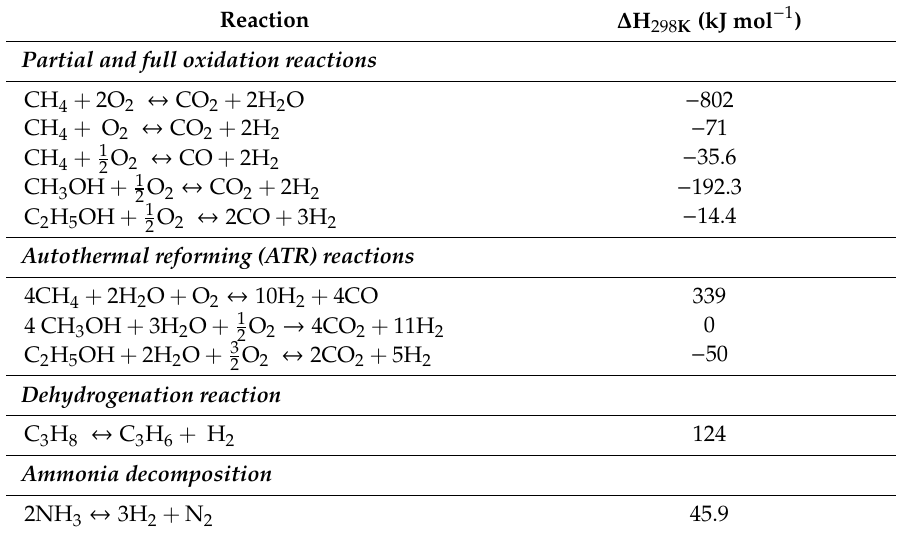
Figure 6. Methane equilibrium conversion in conventional system and comparison with membrane reactors at different pressures. In this case, the membrane reactor technology allows us to achieve the same conversions of a conventional system while working at much lower operating temperatures (550 °C for an MR compared to 850–900 °C for a conventional system). On top of it, as hydrogen is permeating through the membranes, the WGS reaction is shifted towards the products and a downstream separation is not required [20]. In another study, Matsuka et al. [21] performed membrane reactor tests in a packed-bed configuration using nickel-based catalysts coupled with different types of self-supported membranes: 25 and 50 μ m-thick Pd 77 Ag 23 and 100 μ m-thick V and V 92 Ni 8 layers coated on both sides with Pd by magnetron sputtering (1 μ m). The best performance was observed for the Pd-coated vanadium membrane, obtaining a ~45% methane conversion at 400 °C while the permeation flux was 0.09 (mol m − 2 s − 1 ). This is due to higher diffusion rate of hydrogen molecules in vanadium compared to in palladium. However, and to enhance the hydrogen-splitting phenomenon, thin layers of Pd are still required. Silva et al. [22] demonstrated that methane steam reforming can be performed in a packed bed membrane reactor with an up to 47% hydrogen recovery at a 35% methane conversion (at 600 °C). Temperature, K650 700